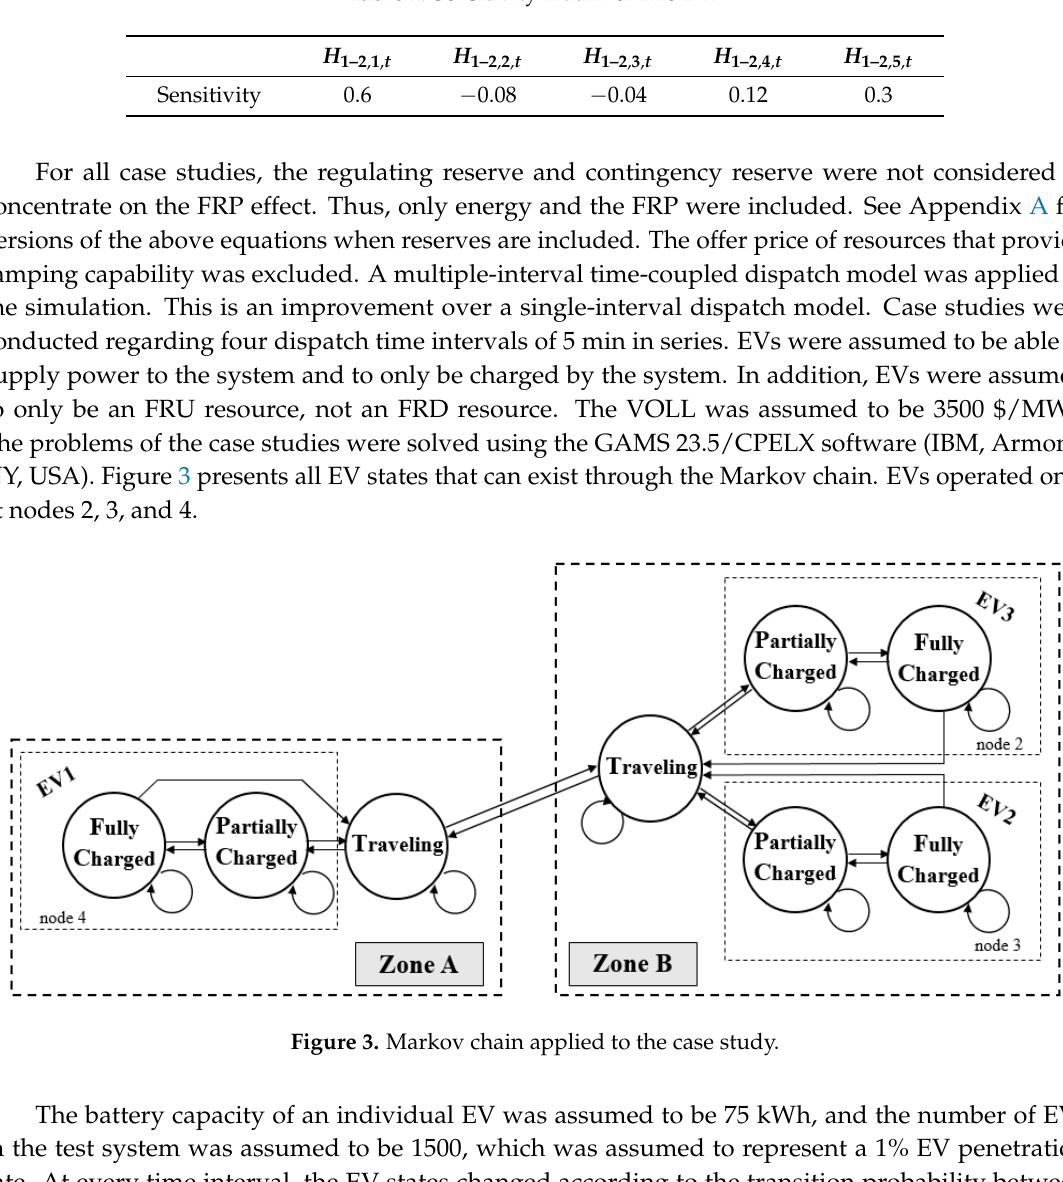
Table 2. Sensitivity matrix of line 1–2.